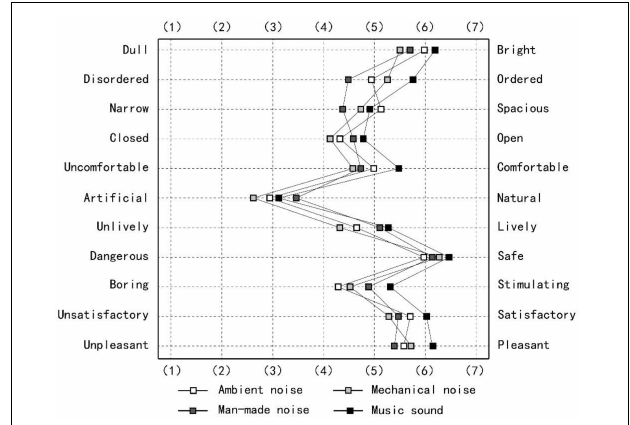
FIGURE 5 | Patients’ bipolar adjective environmental appraisal scores in different healthcare acoustic environments.